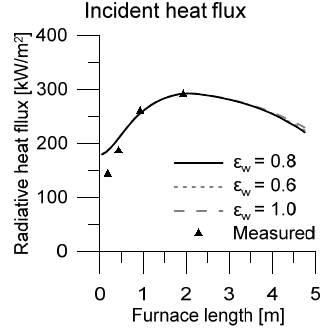
Figure 9. Measured and modelled incident radiative heat flux varying the inner wall emissivity from 0.8 to 0.6 and 1.0.